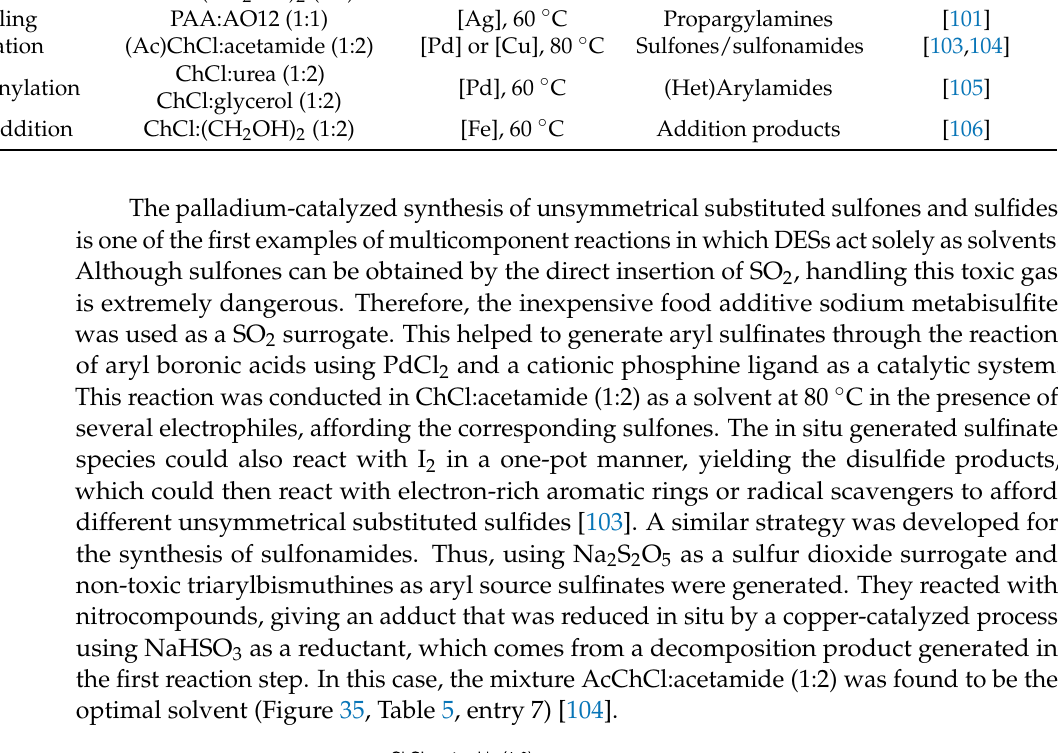
Figure 36. Aminocarbonylation and multicomponent radical addition.